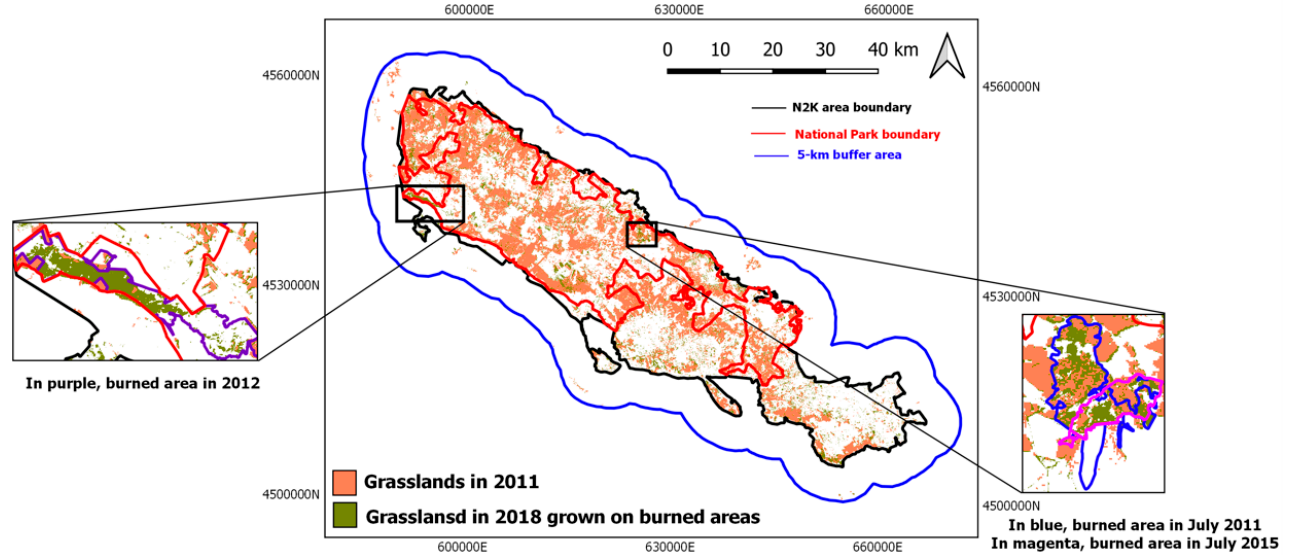
Figure 12. Grasslands mapping for 2011 overlapped on that for 2018: grasslands regrowth areas highlighted in mustard yellow. In the two close-ups on the sides the boundaries of several burned areas mapped by the official fire registry related to fire events happened in 2012 (on the left) and in July 2011 and 2015 on the right are overlaid on the mappings.